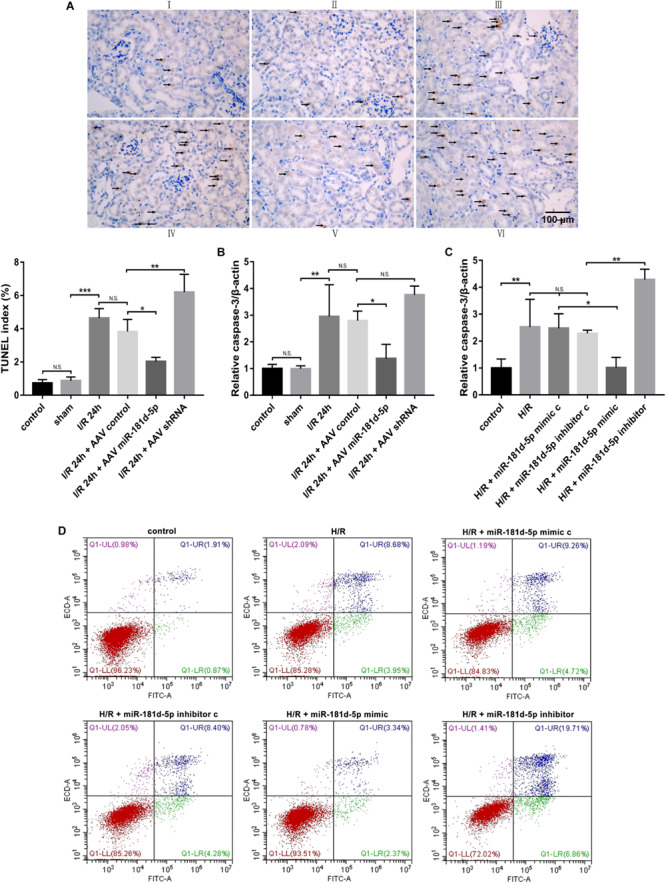
MiR-181d-5p decreased RTEC apoptosis during IRI in mice and H/R in HK-2 cells. (A) Apoptotic kidney cells in mice infused with or without miR-181d-5p, as assessed using TUNEL. TUNEL of representative kidney sections from each experimental group is shown. Colocalization of blue and brown staining in nuclei indicates apoptotic cells, which are indicated with arrows. Scale bar. 100 mm. (I: control; II: sham; III: I/R; IV: I/R+AAV-control; V: I/R+AAV-miR-181d-5p; VI: IRI+AAV-shRNA). Proportions of TUNEL-positive nuclei to total nuclei in renal epithelial cells of mice are shown (n = 3 per group). (B,C) qRT-PCR was used to detect caspase-3 in mouse tissues and HK-2 cells as described in the section “Materials and Methods.” The relative expression of caspase-3 was normalized to that of β-actin (n = 5 per group). (D) Flow cytometric analysis of Annexin V/PI staining showed that hsa-miR-181d-5p decreased the level of programmed cell apoptosis in miR-181d-5p-treated HK2 cells. The data are presented as the means-SDs. *P < 0.05, **P < 0.01, ***P < 0.001.